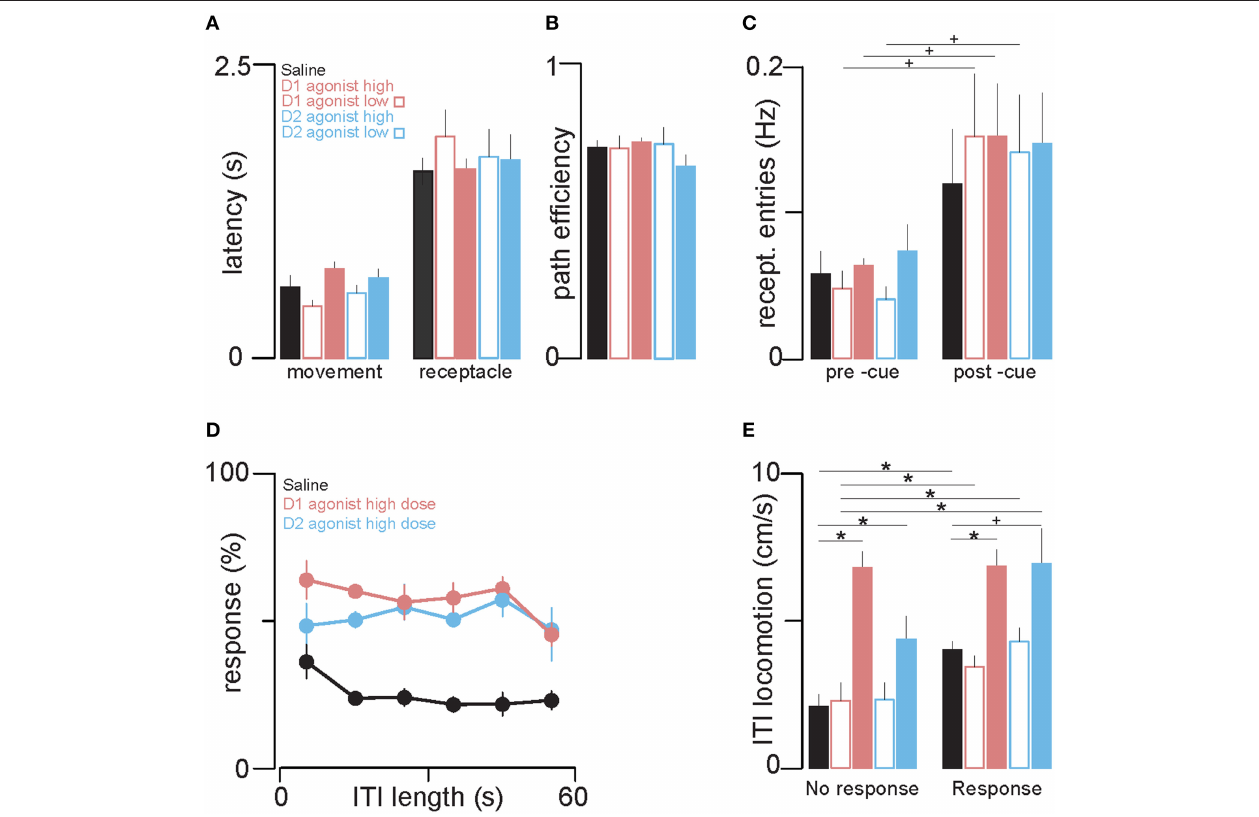
FIGURE 5 | The dopamine agonists increase locomotion, but increased cue responding is not attributable to increased locomotion. (A) The left group of bars shows the effects of injection of saline, D1 and D2 agonists on the mean latency to initiate movement after cue onset, and the right group shows the mean latency to reach the receptacle. Color conventions are the same as in Figures 1D,E . (B) Path efficiency (a measure of directness of approach to the receptacle) was not affected by either agonist or saline. (C) The mean rate of receptacle entry 5s before (left group of bars) and during cue presentation (right group) for trials with a behavioral response. (D) The mean response ratio (%) for different ITI lengths (bin width = 10s) after saline (black), D1 agonist (light red) and D2 agonist (light blue) injection. The probability of a cued response was not significantly correlated with ITI length in any of the treatment groups. (E) The bars show the mean rate of locomotion during ITIs when rats respond (left group of bars) and do not respond (right group) to the subsequent cue. * p < 0.05, + p <